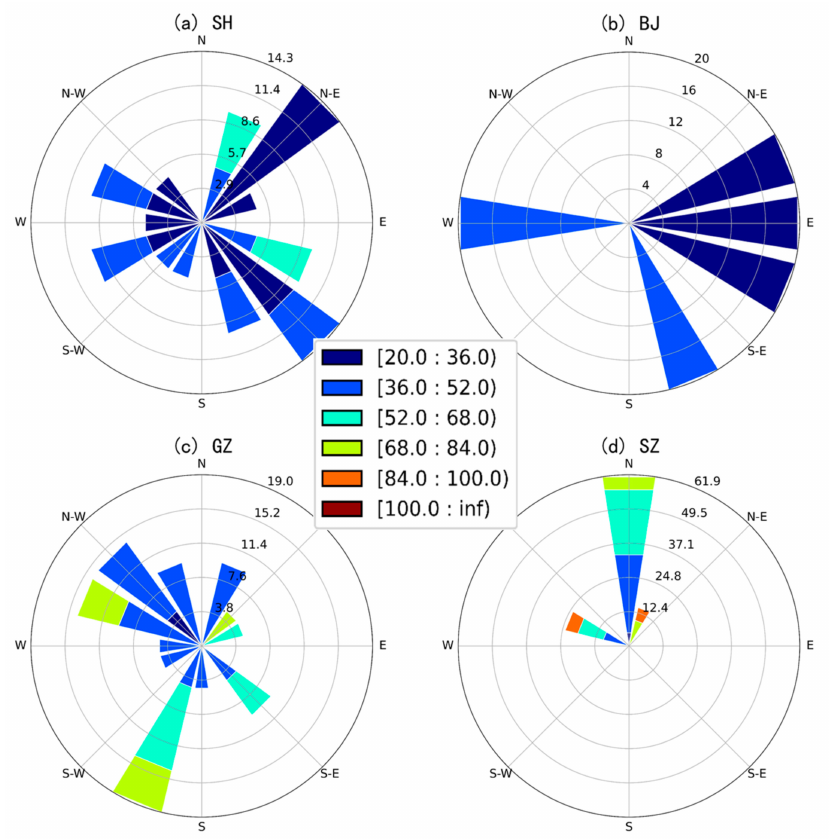
Figure 13. The wind rose to analyze the relative positions between rainfall centroids and geographic location centers (The relative positions between rainfall centroids and geographic location centers are divided into eight directions. The colors of the ribbons indicate the rainfall magnitudes of rainfall centroids, and the length of it indicates the occurrence probability of these magnitudes).